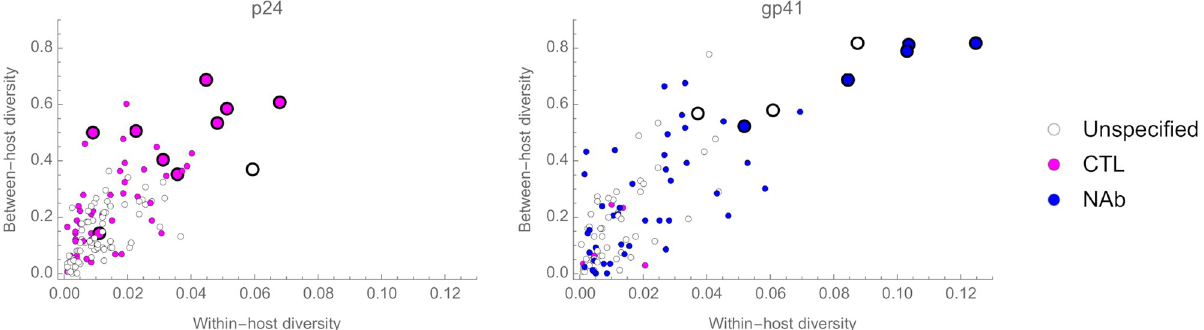
Fig 5. Within- and between-host codon diversity. For every AA position in our region of analysis we determined the within- and between-host codon diversity. Large markers denote AA positions in which we are confident selection is occurring in at least one individual. Markers are coloured if they are associated with changes in sensitivity to CTLs or compensatory mutations (pink) or NAbs (blue). The site confidently under selection in p24 but which is unspecified (Gag residue 286) is possibly associated with CTL escape. The sites confidently under selection in gp41 but which are unspecified (Env residues 641, 644, and 648) possibly reflect selection associated with NAbs; these are all within an epitope region targeted by the neutralising antibody HGF24 in some African Isolates[58]. Where an AA position is implicated in CTL and NAb responses, for clarity they are coloured in